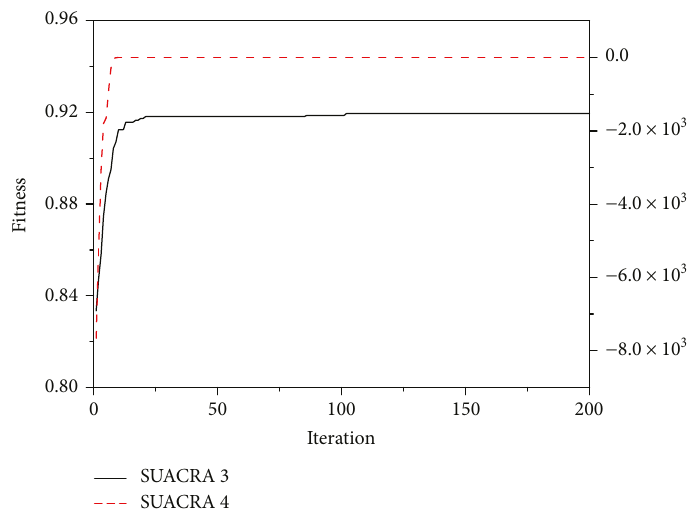
Figure 10: The fi tness values throughout the optimization process of SUACRA 3 and Figure 10, the fi tness values of the two SUACRAs reach the convergence points within 150 iterations.